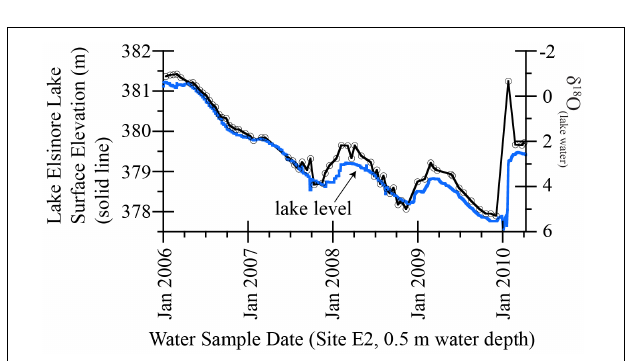
FIGURE 4 | Lake Elsinore lake level (m) and measured lake water (0.5 m water depth) δ 18 O values.